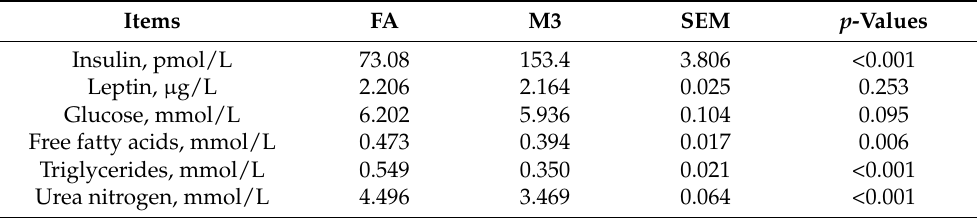
Table 5. Effects of feeding frequency on blood profile in growing–finishing